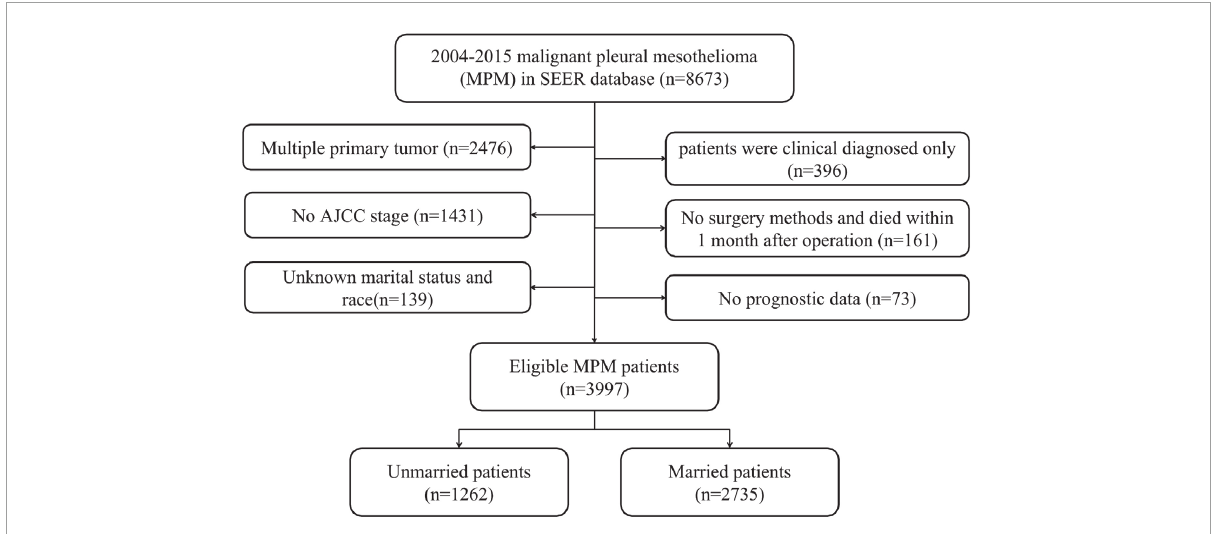
FIGURE1 Flowchart showing the patient screening